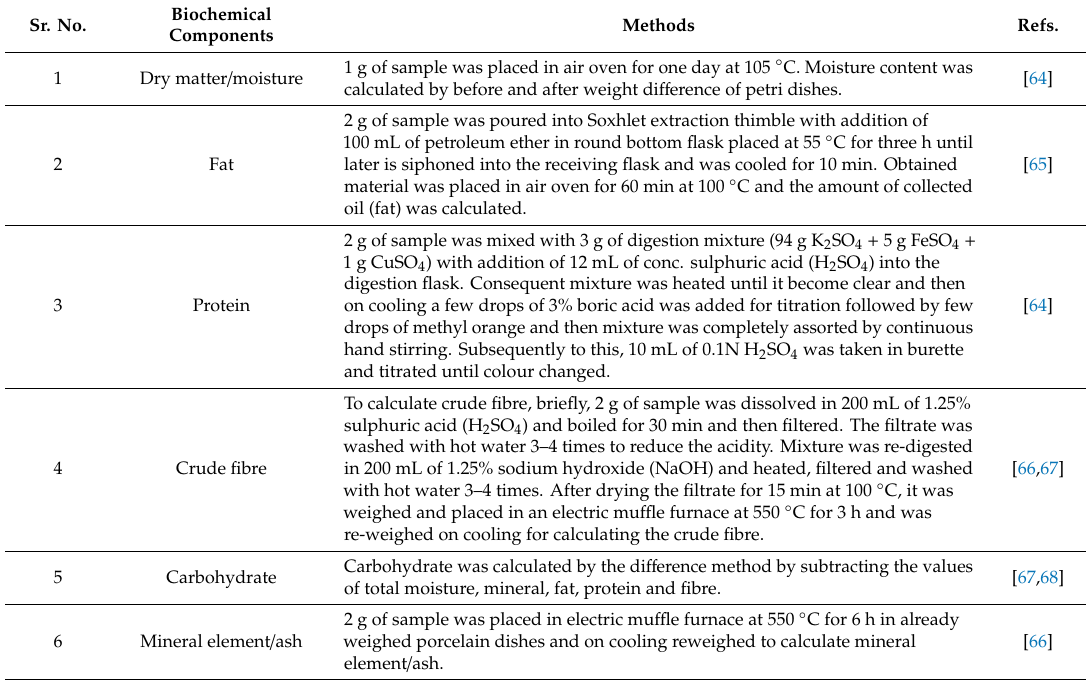
Table 4. Methods for the determination of biochemical components of S .